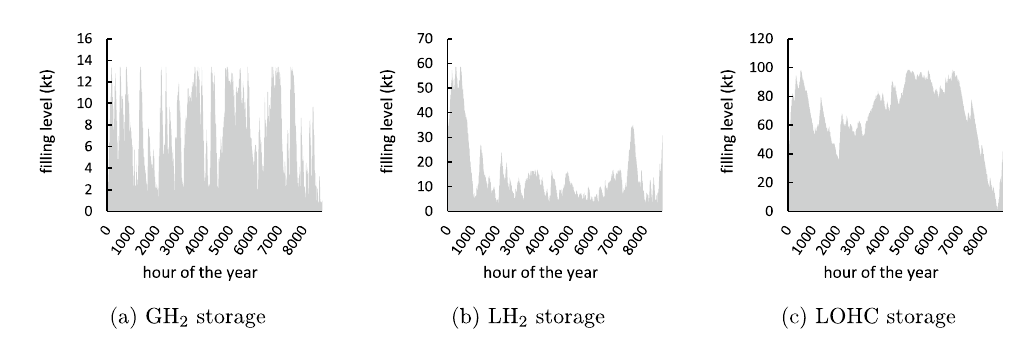
Figure 3. Distribution of hydrogen production, hydrogen demand, and electricity prices, exemplary for OS+ LH 2 in scenario Res 80- Dem 25.